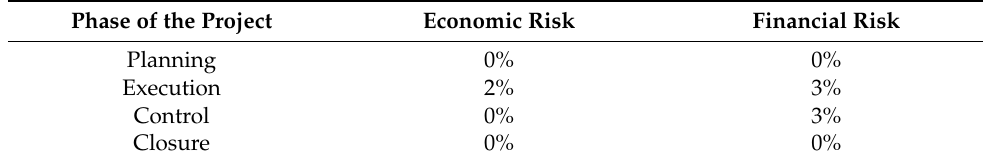
Table 7. Evaluation of economic and financial risks in the different phases of CHP projects. Phase of the Project Economic Risk Financial Risk